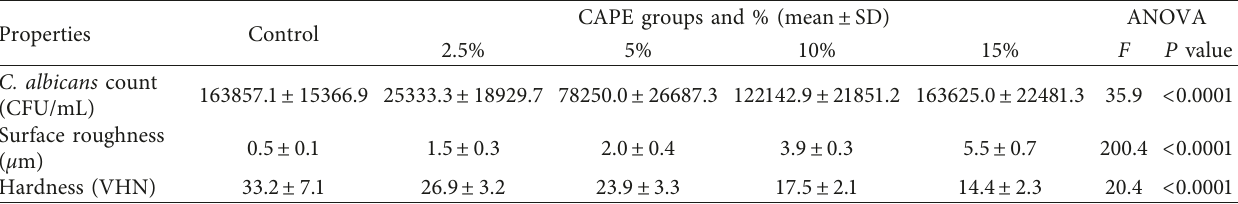
Table 1: Mean, standard deviation (SD) and significances between groups for all tested properties according to CAPE concentrations. Properties